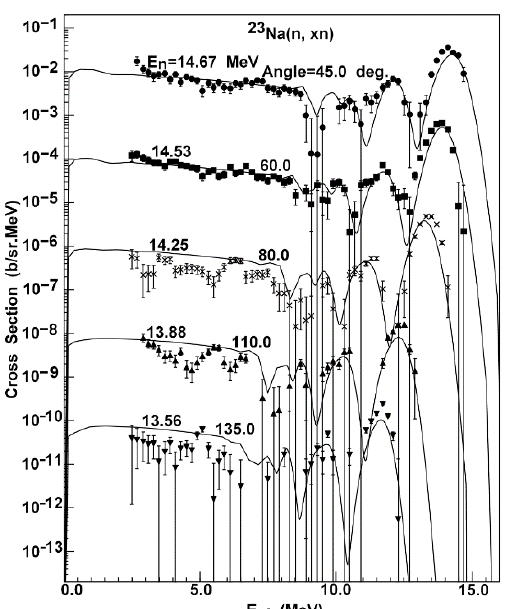
Fig. 11. The comparison of CENDL-3.2 (solid line) for the double differential cross sections of 23 Na (n, xn) and the available experimental data